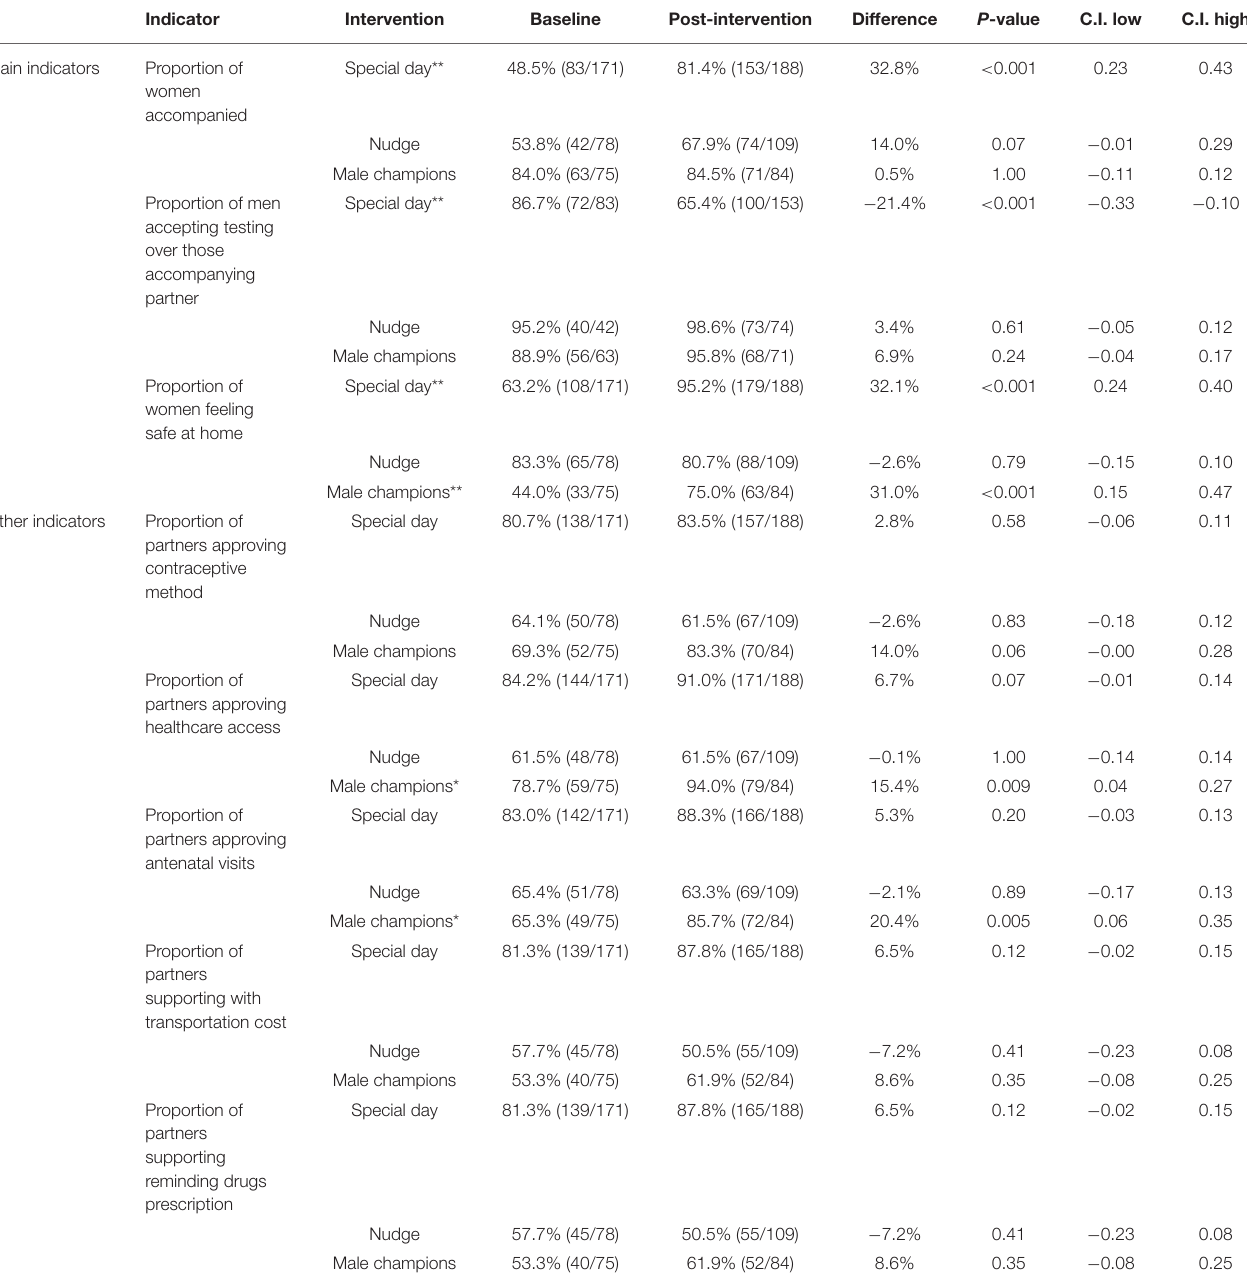
TABLE 4 | Intermediate outcomes at baseline and